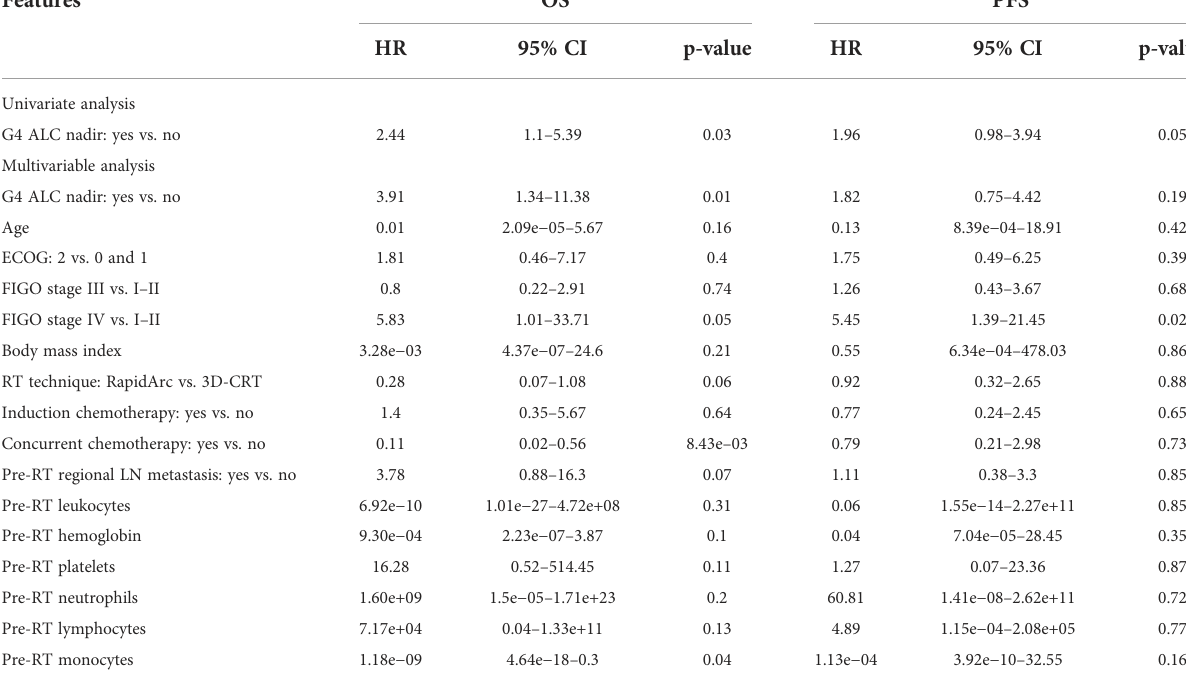
TABLE 2 Univariate and multivariable analysis of potential factors associated with survivals.